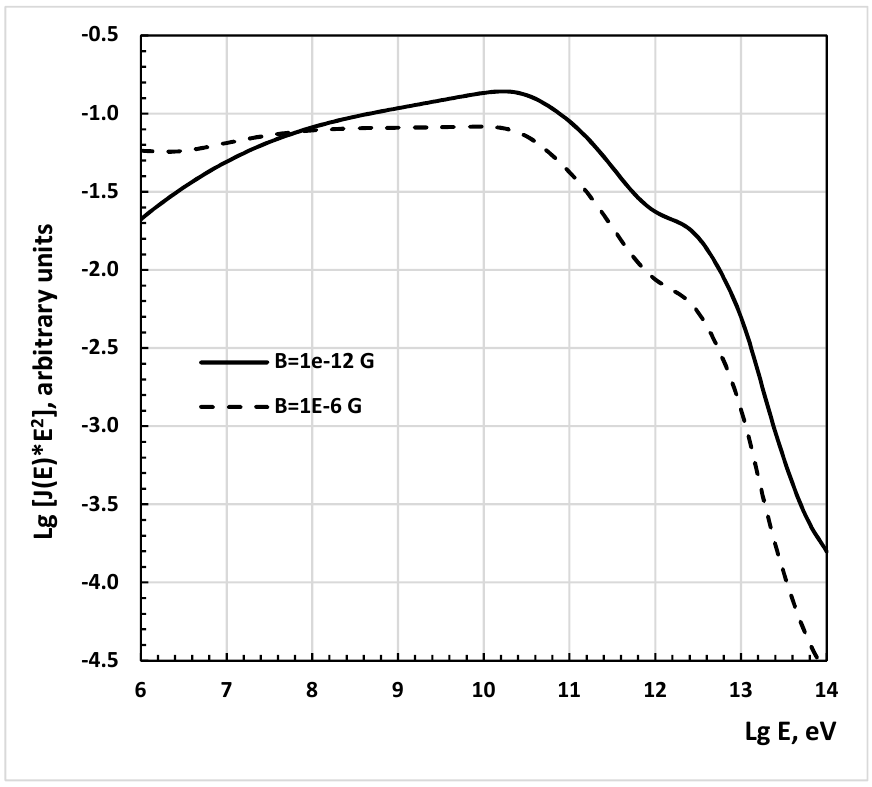
Figure 1. The spectra near the Earth of diffuse cascade gamma-rays produced by UHE protons in the extragalactic magnetic field B of 10 −6 and 10 −12 G. The spectra when EGMF is B < 10 −12 G and B = 10 −12 G coincide and are not shown in the figure.